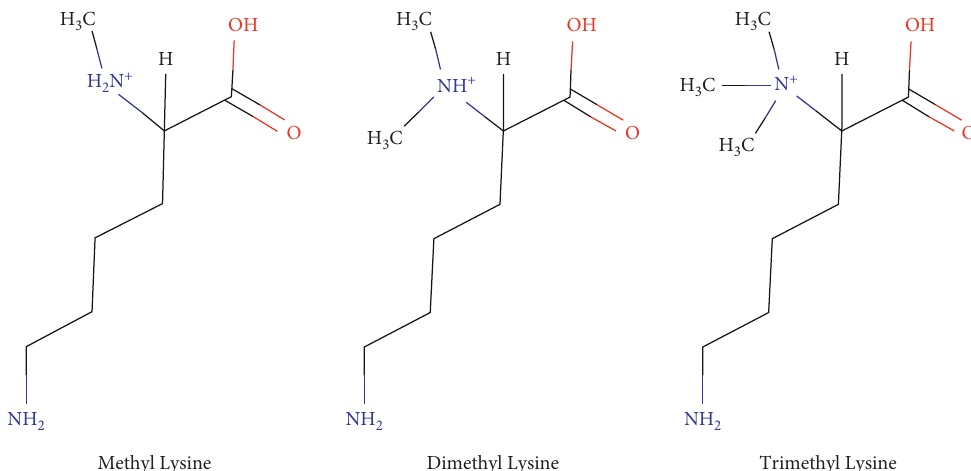
Figure 1: Potential methylation states of lysine. Generation of these three species is catalyzed by lysine methyltransferases (KMTs) and lysine demethylases (KDMs) through the addition and removal of methyl groups,